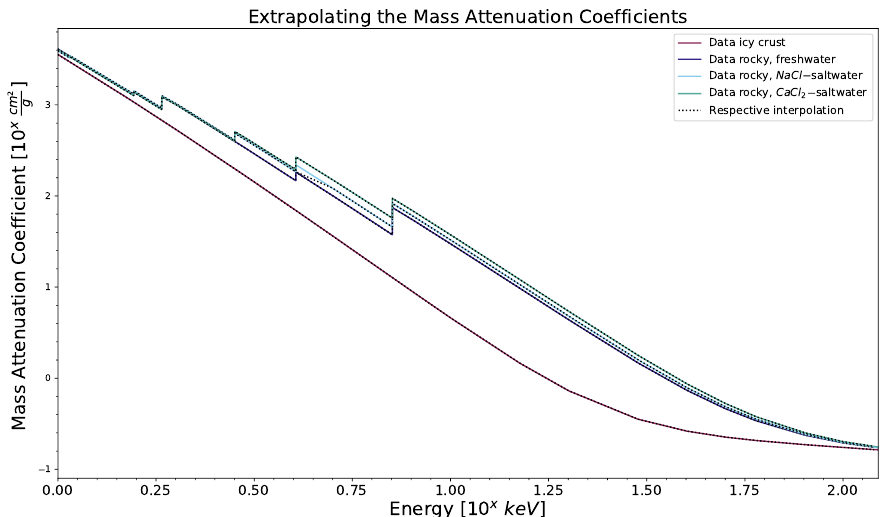
Figure A5. A plot of mass attenuation coefficients across a photon energy range, with data obtained from [20] (in colored, solid lines) and respective interpolated data (as black, dotted line) for four surface